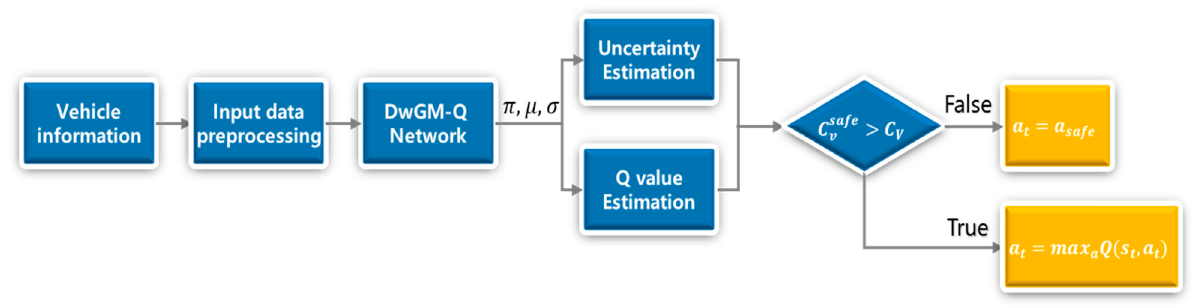
Figure 2. Flow chart of DwGM-Q decision-making process.